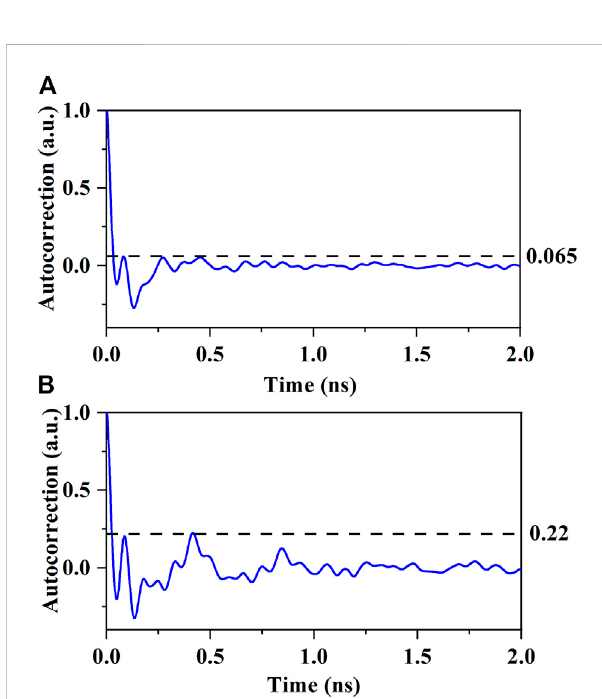
FIGURE 4 Comparison of TDS suppression between the proposed laser with the DBR and the equivalent end-face feedback structure (A) Auto-correlation function of the proposed laser with the DBR. (B) Auto-correlation function of the equivalent end-face feedback